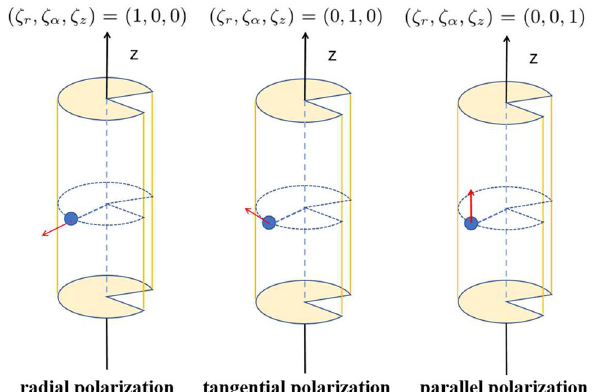
Fig. 2 Polarization schematic: the left panel to the right panel repre- sent the radial polarization, the tangential polarization and the parallel polarization,